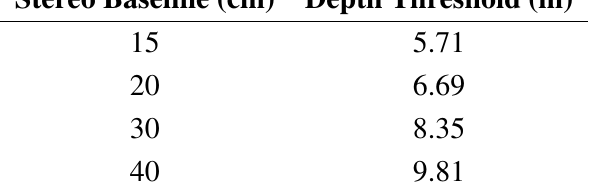
Table 1. Optimal depth thresholds for different stereo baselines and fixed focal length f = 202 and image size (320 , 240) x